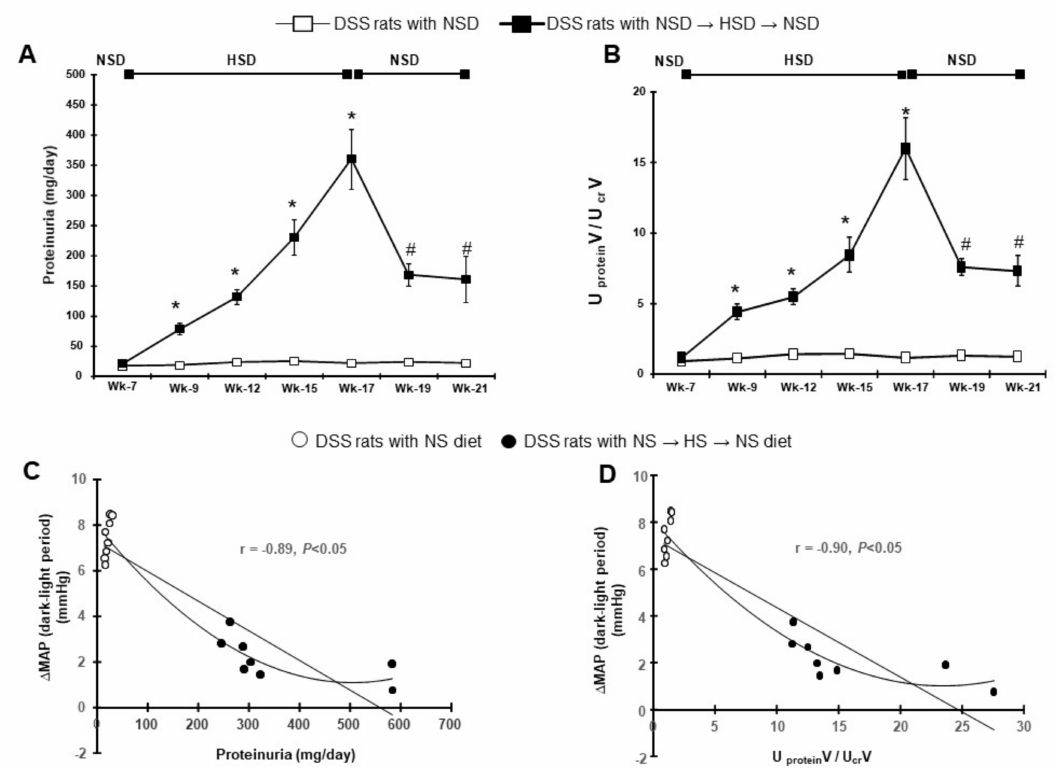
Figure 5. E ff ects of HSD on urinary protein excretion. ( A ) The 24-h urinary protein excretion, and ( B ) the urinary protein and creatinine (UproteinV / Ucr.V) ratio. ( C ) Correlation between di ff erences in active and inactive period MAP and level of urinary protein excretion. ( D ) Correlation between di ff erences in active and inactive period MAP and urinary protein–creatinine ratio. * p < 0.05 vs. DSS rats